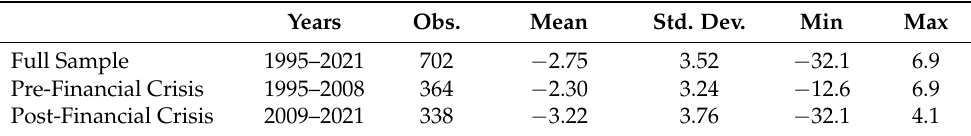
Table 1. Descriptive